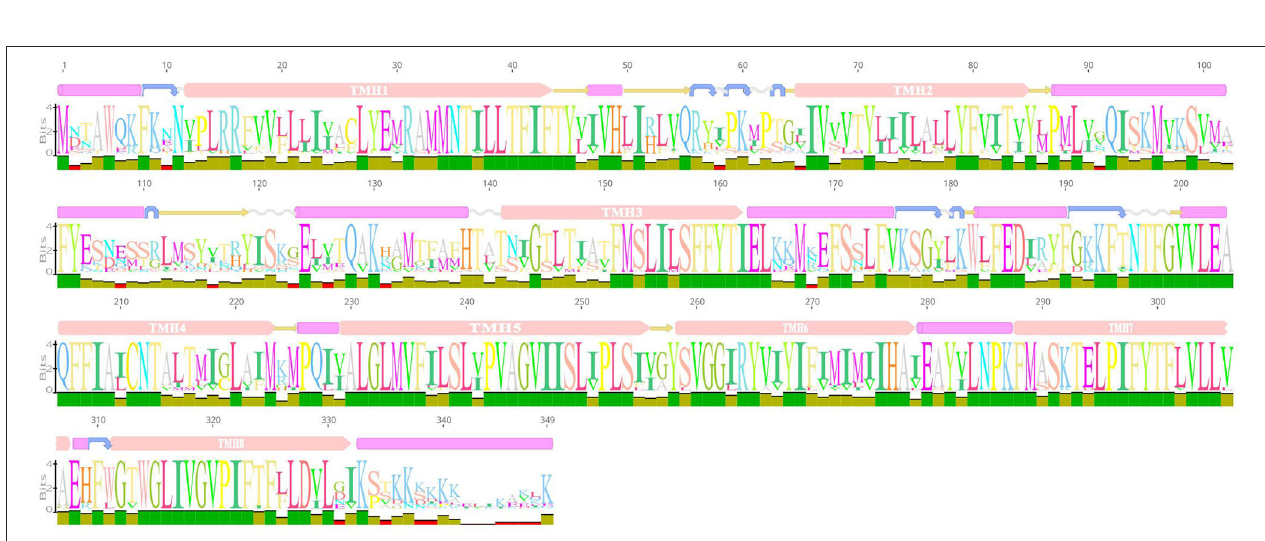
FIGURE 2 | Weblogo of AI-2E protein of Lactobacillus acidophilus CICC 6074 and its homologs. The first layer shows the predicted secondary structure and functional domains of AI-2E protein. The pink bars represent an α -helix, the blue arrows represent the corner, the yellow arrows represent the β -fold, and the pink bars marked with transmembrane helix (TMH) are the predicted transmembrane helices. The letters of different sizes in the second layer represent the size of similarity of homologous sequences at that locus, larger letter means higher similarity. The color block in the third layer represents the conservativeness of the sequence and the green color represents that the region is